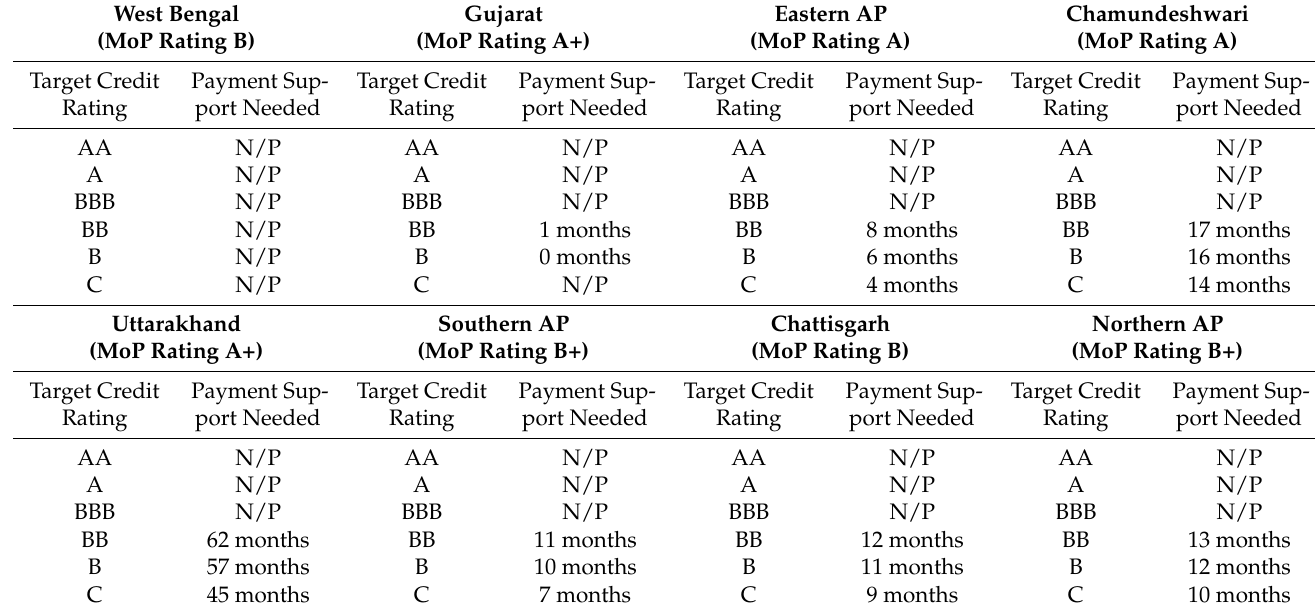
Table 6. DISCOM-wise table of size of Payment Support Needed to achieve target credit ratings [15]. “N/P” indicates PSM is not needed/cannot achieve the target rating. MoP stands for Ministry of